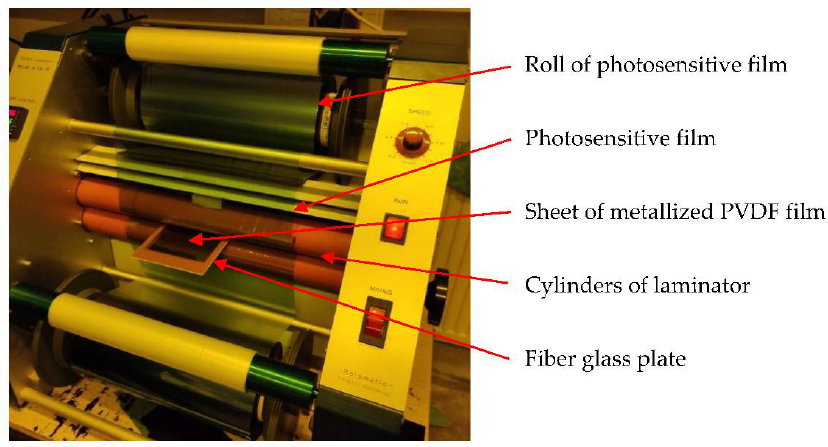
Figure 2. Application of the supporting fiber glass plate in the laminator.